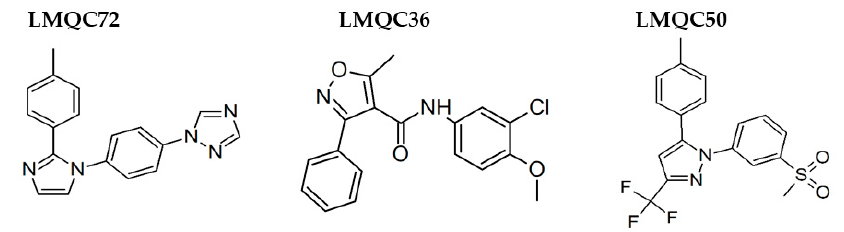
Figure 8. Promising bioactive compounds.